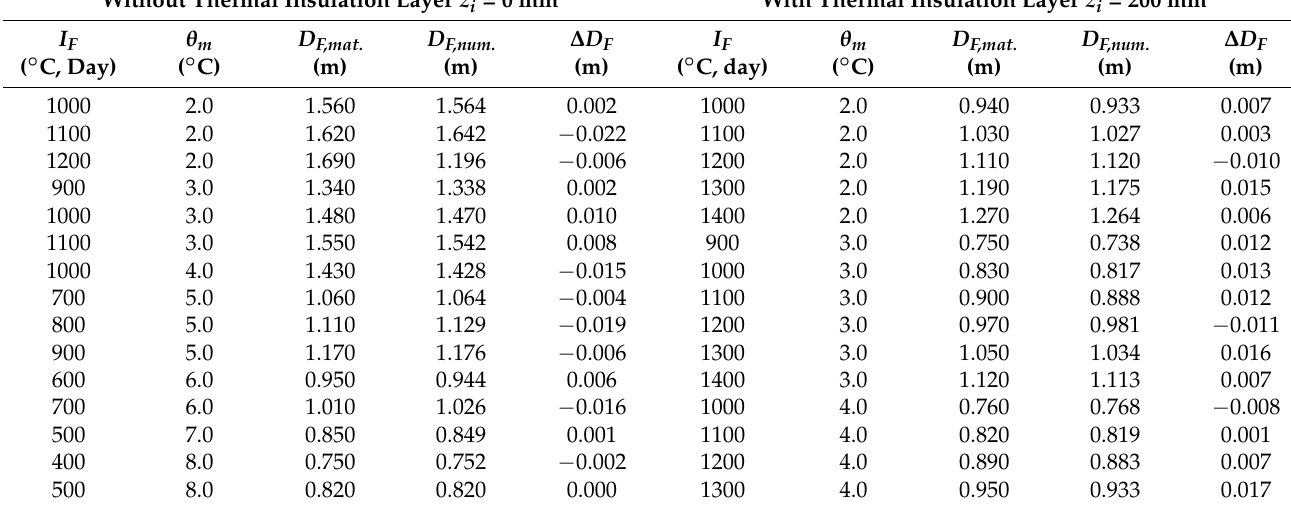
Table 7. Deviations of the values determined by the mathematical and numerical method for the freezing depth of railway line construction D F depending on air freezing index I F and average annual air temperature θ m (sub-ballast layers with a built-in thermal insulation layer made of composite foamed concrete 200 mm thick and also without thermal insulation